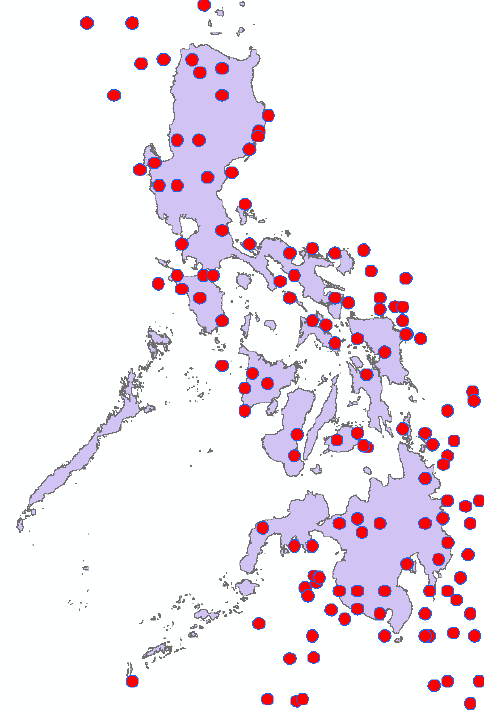
J. Mar. Sci. Eng. 2021 , 9 , x FOR PEER REVIEW Figure 10. Earthquakes with at least a 6.5 magnitude. Figure 10. Earthquakes with at least a 6.5 magnitude.